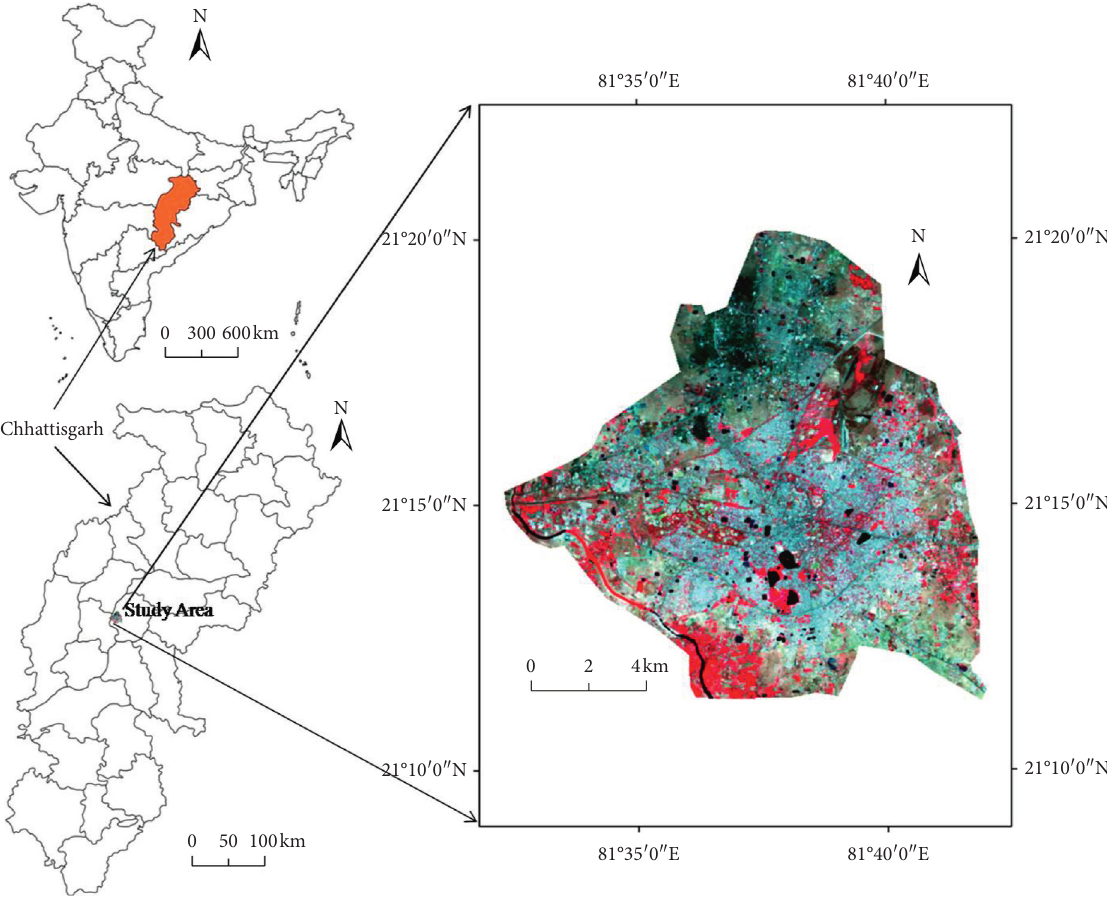
Figure 1: Location of the study area.